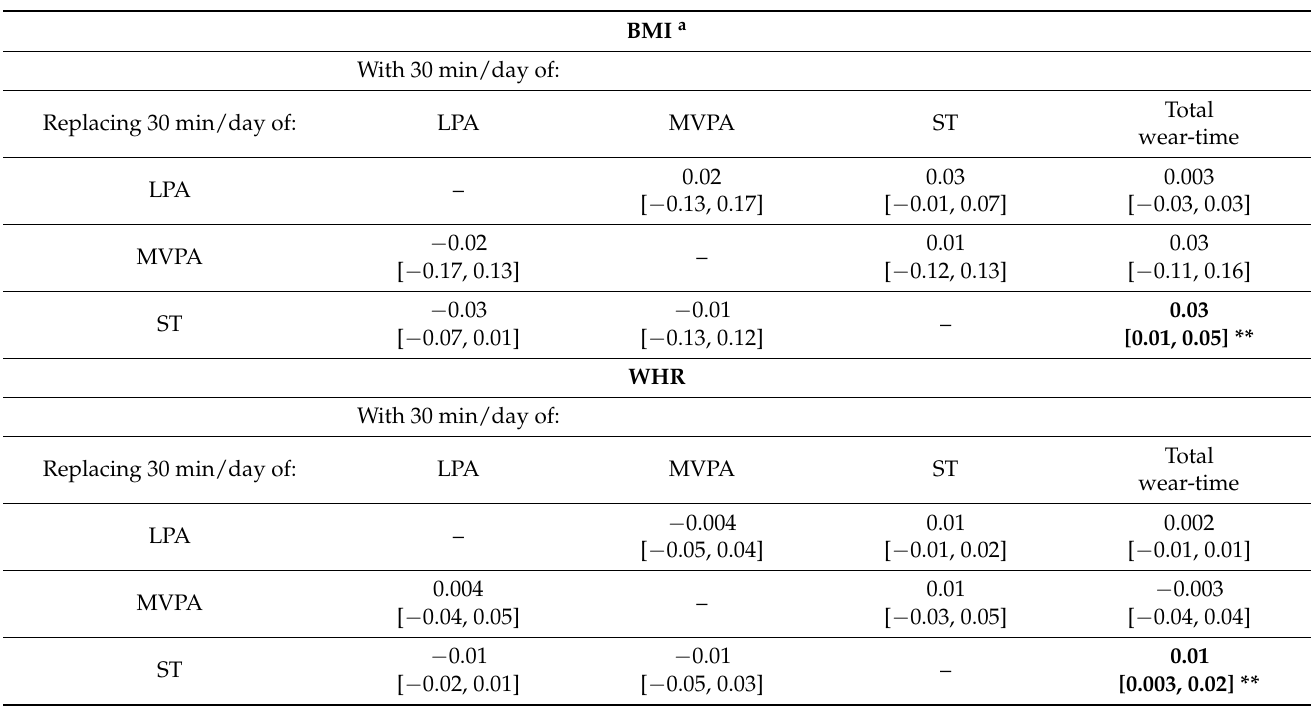
Table 3. Cross-sectional replacement effects ( β [95% CI]) at follow-up of substituting 30 min of non-school time LPA, MVPA, and ST on BMI, WHR, and BF% in girls ( n = 77). BMI a With 30 min/day